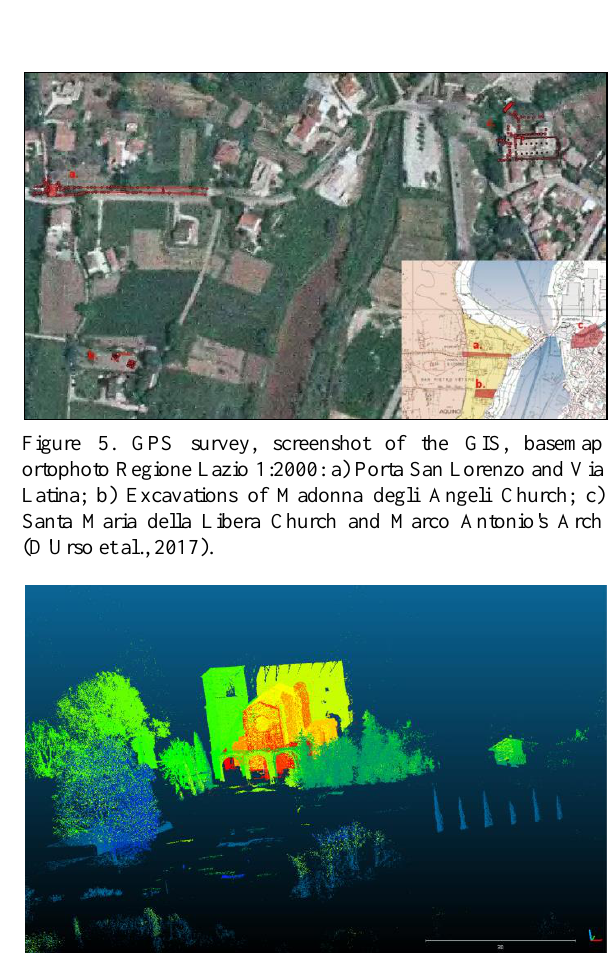
Figure 4. On the field activities during workshops and tutorials in Havana (Cuba) and Dehradun (India) to give the participants a basic introduction on integrated surveys with geomatics techniques followed by practice activities.